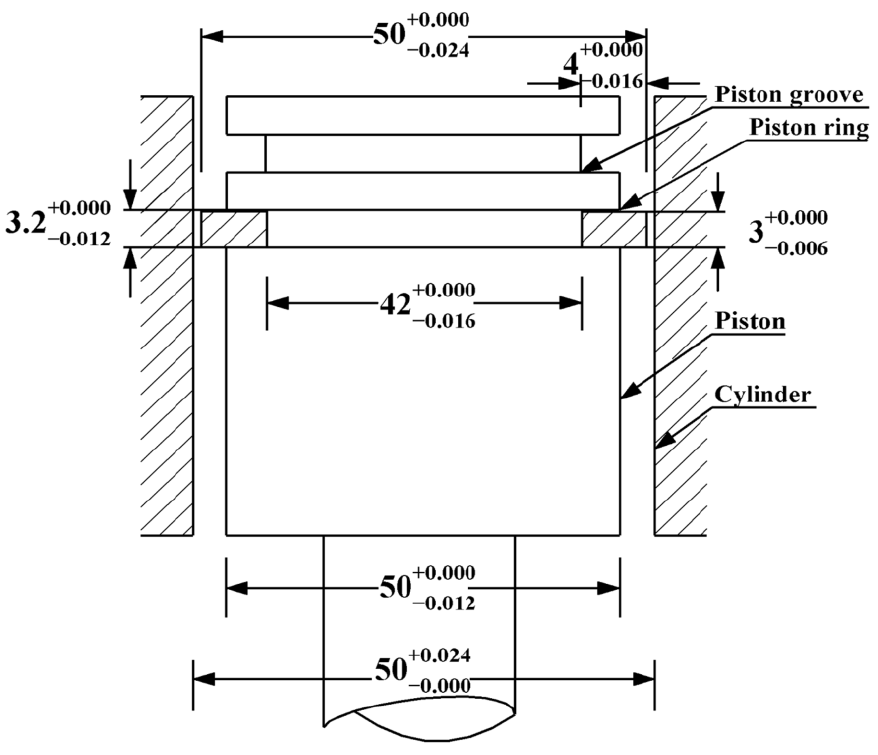
Figure 4. Piston and cylinder assembly.